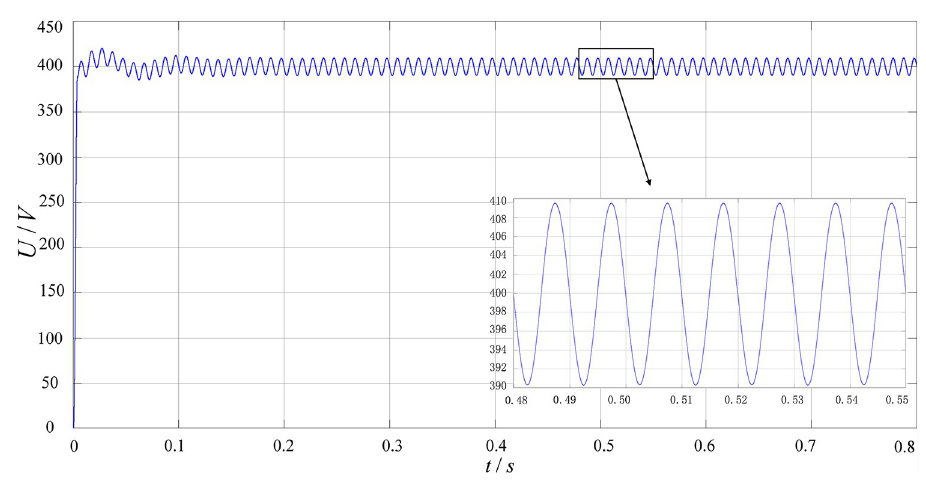
Fig 17. PFC output voltage